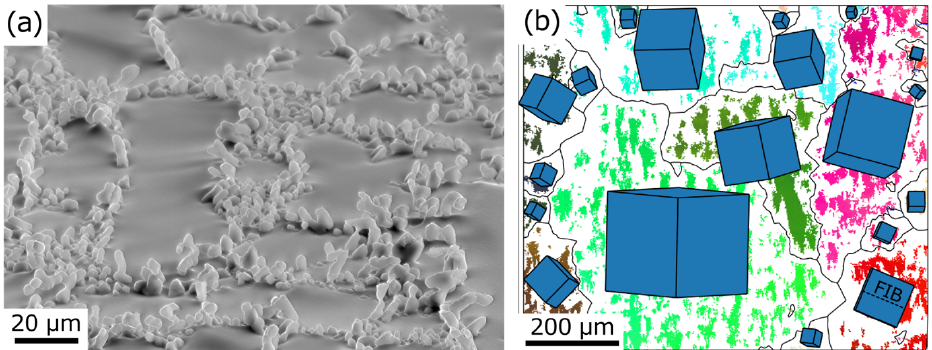
Figure 1. ( a ) SEM image from an electropolished sample of alloy Mg0.45Cu0.5 tilted 70°, showing eutectic Si particles. ( b ) EBSD map showing grain orientations by cubes with faces parallel to {001} Al planes. The dashed line marked “FIB” shows an example plane used for FIB liftout to obtain a <001> viewing direction in TEM.